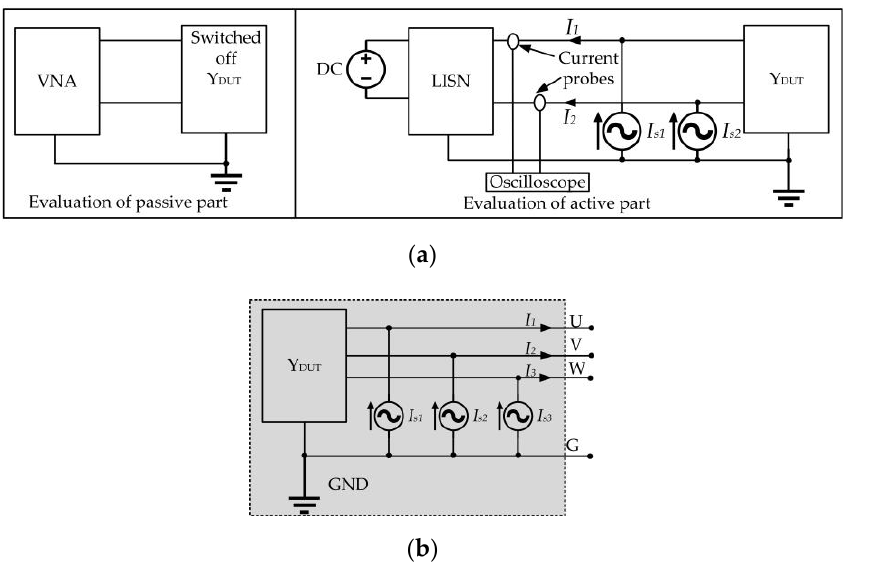
Figure 1. ( a ) Principle drawing of the black-box modelling technique in [12]: Identification of passive (left panel) and active (right panel) parameters separately. ( b ) Black-box model of the three-phase inverter system.